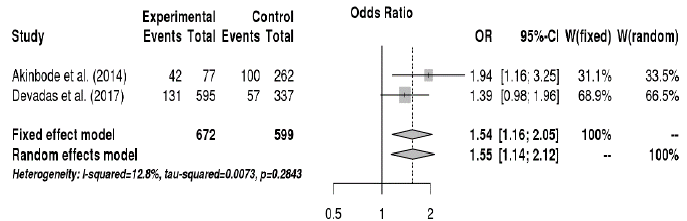
Figure 4. Forest plot about the relationship between caffeine consumption and vocal disorders.